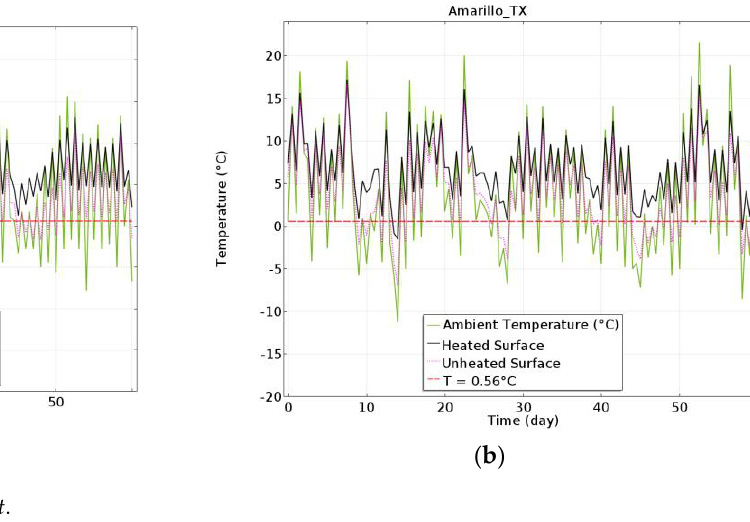
Figure 9. Temperature profile on the 2-D axisymmetric surface and conductive heat flux repre- sented by arrows: (a) system without insulation and (b) system with insulation.